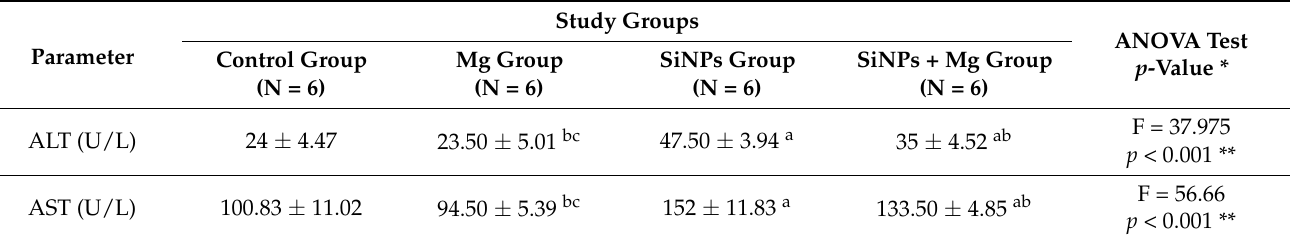
Table 2. Comparison between the studied groups regarding the serum alanine aminotransferase and aspartate aminotransferase levels in the studied groups.